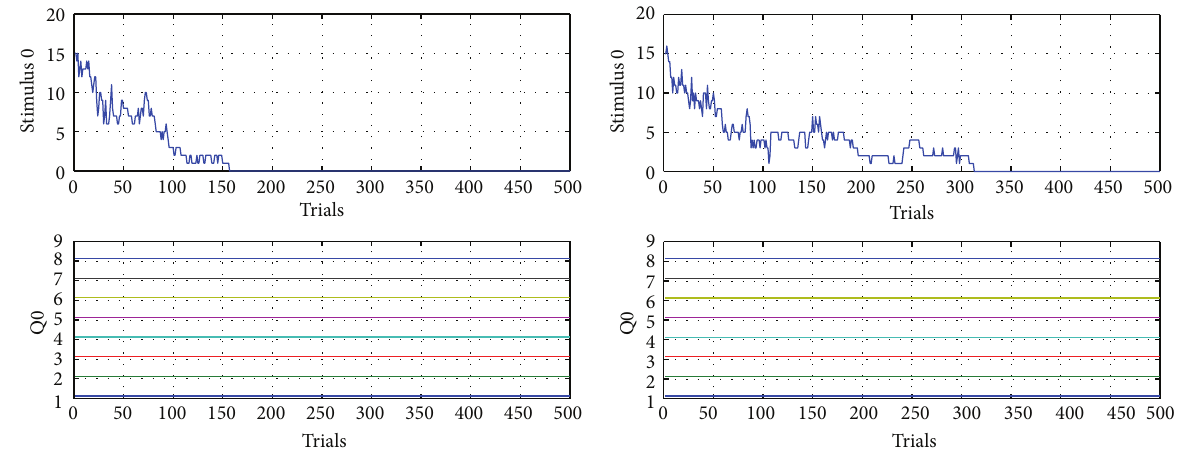
(a) The evolution of the number of the searching predators based on the (b) The evolution of the number of the searching predators based on improved Q -learning conventional Q -learning Figure 4: The evolution of the number of the searching predators.